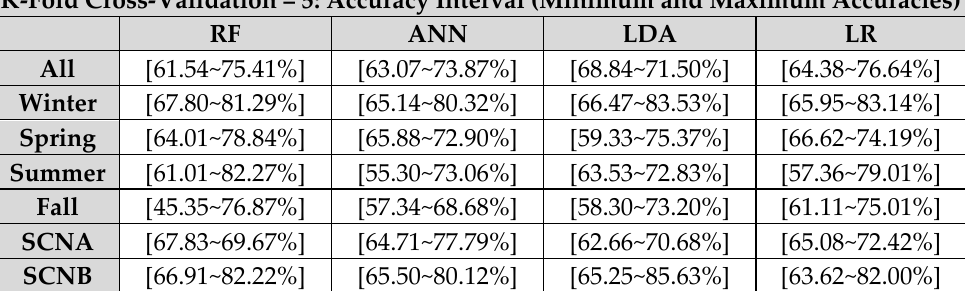
Table 10. K-fold cross-validation, indicating the accuracy intervals obtained per algorithm for global and specific models (minimum and maximum accuracies).